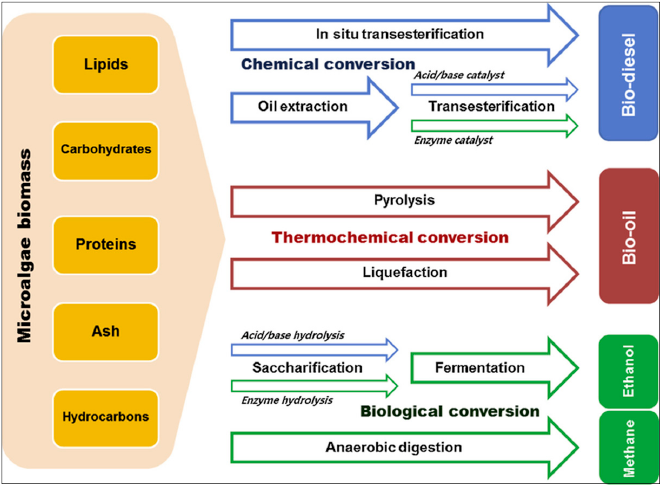
Figure 3. Several thermochemical and biochemical practices for the generation of biofuels from microalgal biomass, adapted from [43].